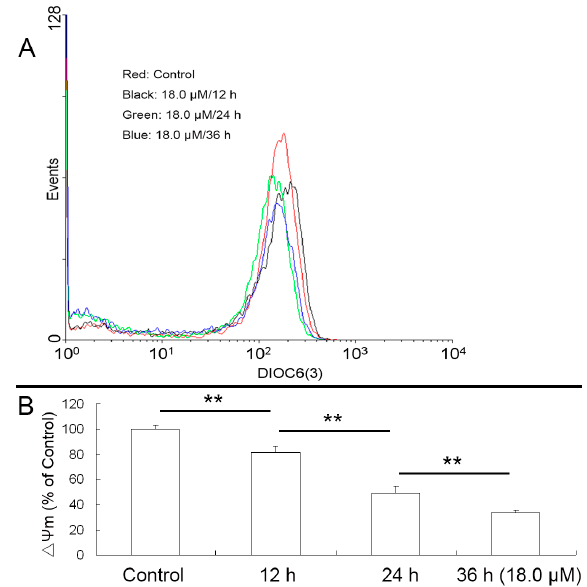
Figure 4. Decrease of ∆Ψ m was observed after A549 cells were exposed to DEFL1 showing a time-dependent pattern. ( A ) Reduction of ∆Ψ m measured by flow cytometry; ( B ) A549 cells ∆Ψ m at different time was expressed as a percentage of control. ** p < 0.01.